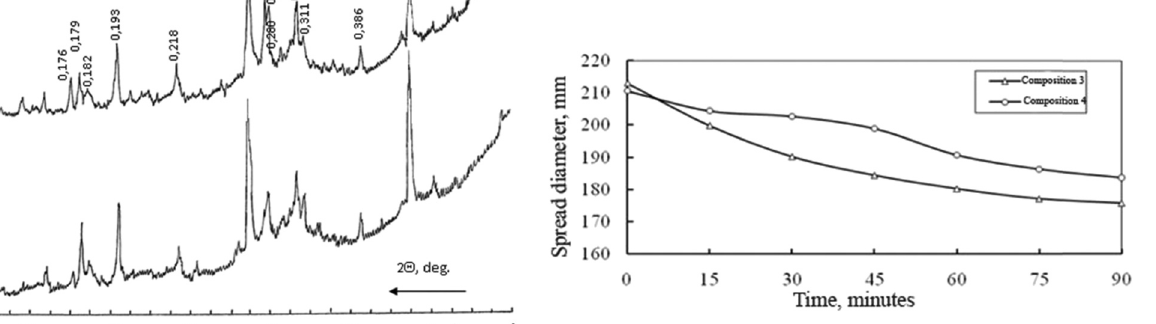
Figure 9: Change in the fl owability of cement pastes with CNTs and ASM ( composition No. 3 ) and without CNTs ( composition No. 4 ) over